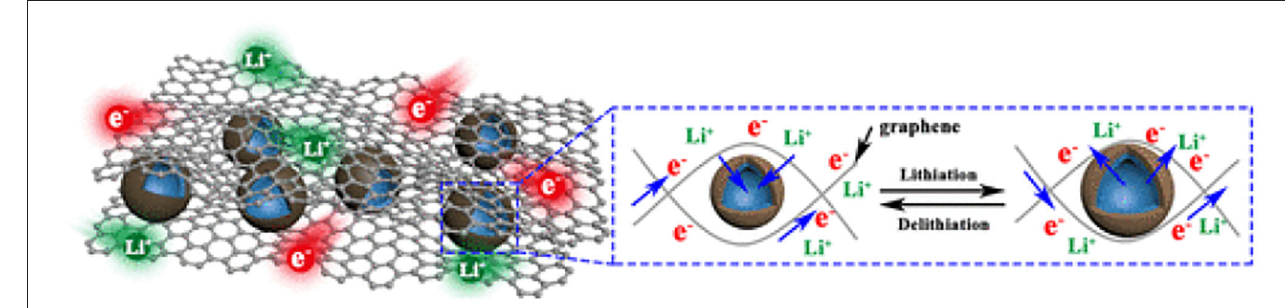
FIGURE 1 | Illustration of the reversible Li-ion storage in G@C@SnO 2 . Reproduced from Wu et al.